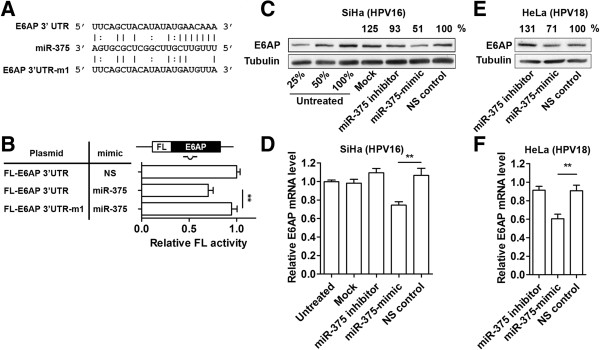
miR-375 directly targets and represses E6AP. (A) Sequence of putative miR-375 binding site in the 3′UTR of E6AP. E6AP 3′UTR-mut was generated by disrupting base paring of four nucleotides, positions 2 to 5. (B) Relative FL repression effects of miR-375 on the FL-E6AP reporter. Results were compared with FL-E6AP co-transfected with NS control for statistical analysis. (C) E6AP protein level changes in SiHa cells transfected with miR-375 inhibitor, -mimic, or NS control were analyzed by Western blot. Tubulin expression was used as internal control. 25%, 50%, 100% amounts of untreated cell lysates were included to calibrate the semiquantitative analysis. (D) In parallel, relative endogenous mRNA levels of E6AP from SiHa cells transfected with miR-375 inhibitor, -mimic, or NS control were measured using qRT-PCR. (E) E6AP protein level in HeLa cells transfected with miR-375 inhibitor, -mimic, or NS control was analyzed by Western blot. (F) Endogenous E6AP mRNA level in HeLa cells were measured 48 h post-transfection. Results are expressed as mean ± SD from at least three independent experiments. **p < 0.01.